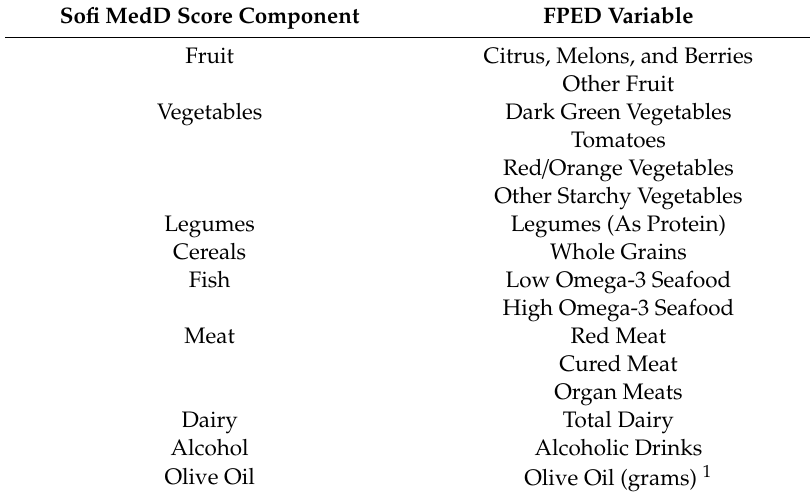
Table 1. FPED intake variables included in Sofi et al. MedD score